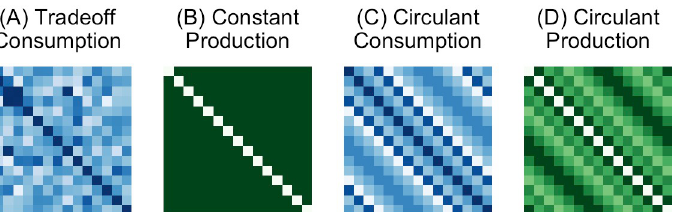
Fig 2. Example consumption and production structures. Each panel is a visualization of the different consumption and production patterns which satisfy our analytical criteria. Darker colors indicate larger values. (A) The tradeoff parameterization of the consumption matrix C . C is symmetric with identical row (or column) sums and diagonal coefficients all set to C . (B) The constant parameterization of the production matrix P . Each entry off-diagonal entry is d set to 1 , while the diagonal entries are set to 0. (C) The circulant parameterization of the consumption matrix. Each S (cid:0) 1 row of the matrix is a permuted version of the previous row and the diagonal entries are all set to C parameterization of the production matrix. Each row of the matrix is a permuted version of the previous row and the diagonal entries are set to 0.